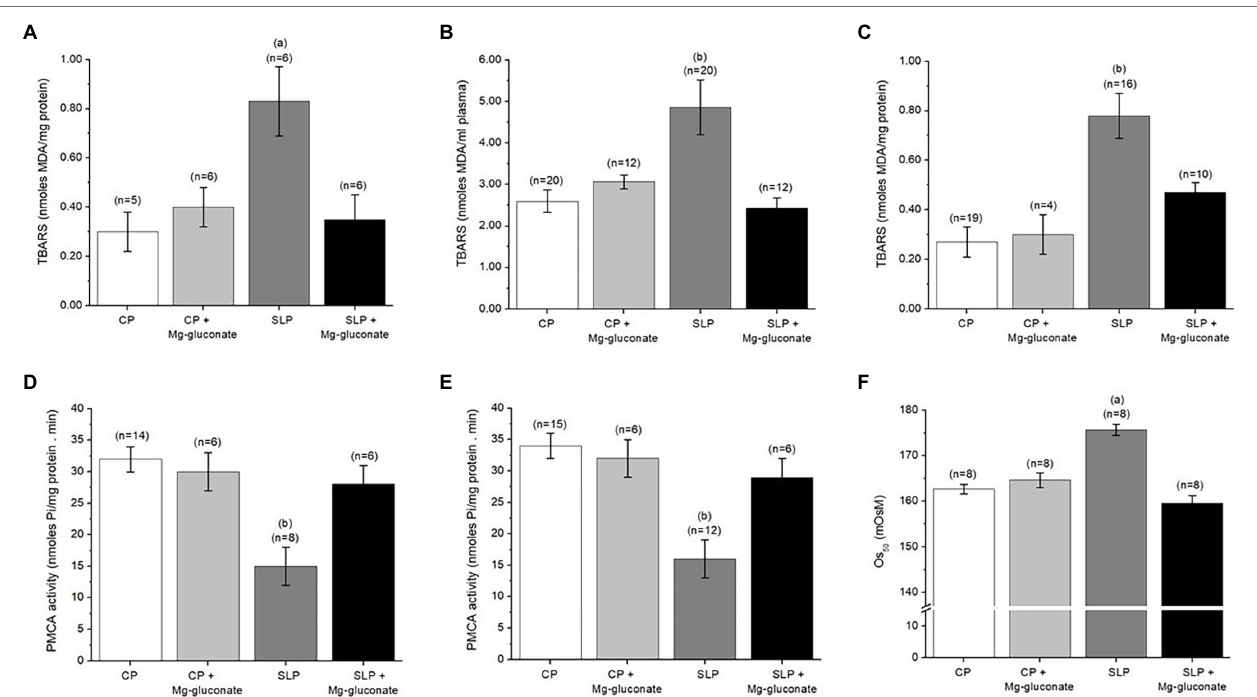
FIGURE 2 | Mg-gluconate alleviated the level of oxidative stress, the reduction of the PMCA activity, and the osmotic fragility of red blood cells produced by salt overloading of pregnant rats during the last week of pregnancy. (A-C) Effect of the treatment with Mg-gluconate on TBARS in red cell ghosts (A) , blood plasma (B) , and placental homogenates (C) from control (CP) and salt-loaded pregnant rats (SLP). (D,E) Effect of the treatment with Mg-gluconate on PMCA activity in red cell ghosts (D) and placental homogenates (E) from CP and SLP. (F) Effect of treatment with Mg-gluconate on the osmotic fragility (OS 50 ) of intact red blood cells from CP and SLP. OS 50 is defined as the osmolar concentration that produces 50% hemolysis of the added red blood cells. The lysis was performed as indicated in the Materials and Methods section. Pregnant female Sprague–Dawley rats (bodyweight 225–250 g, 3 months old) were kept drinking either tap water (CP) or a solution of 1.8% NaCl (SLP), during the last week of their pregnancy, with and without Mg-gluconate in the drinking solution. Values are means ± S.E. Comparisons between treatment conditions were assessed by one-way ANOVA with the post-hoc analysis with the Student–Newman–Keuls test. Value of p for the ANOVA test was <0.01 (Panel A ) and < 0.001 (Panels B–F ). (a) p < 0.01 vs. CP, vs. SLP+Mg-gluconate. (b) p < 0.001 vs. CP, p < 0.01 vs.